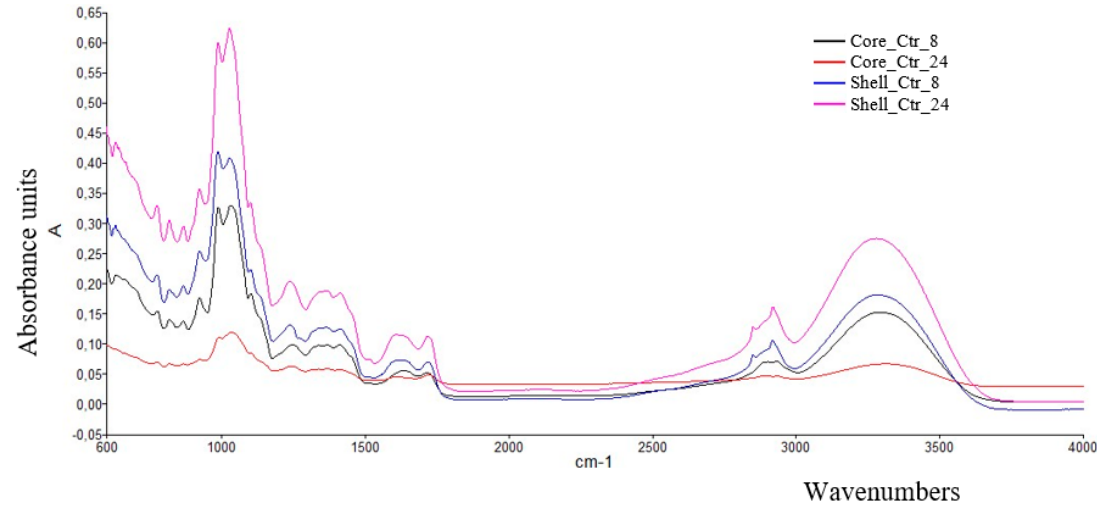
Figure 2. As-collected FT-IR spectra of the control samples of the wounded pineapple shell and core. Ctr_8: control stored at 5 ± 1 °C for 8 h; Ctr_24: control stored at 5 ± 1 °C for 24 h.